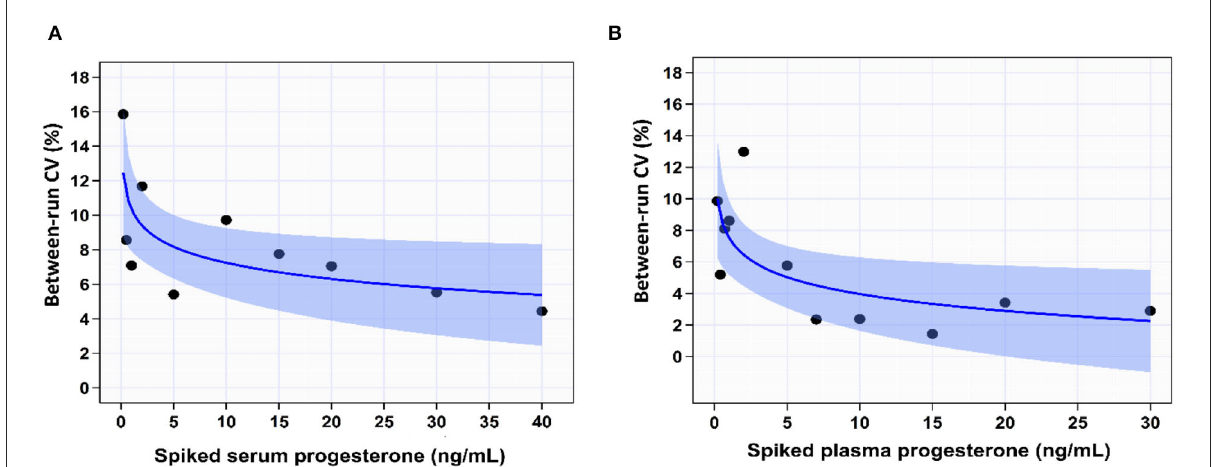
FIGURE3 The coefficient of variation percentage (CV%) indicated the between-run precision of IMMULITE ® 2000 XPi P4 immunoassay across the spiked serum (A) and plasma (B) progesterone concentrations. The solid blue lines are the best-fit regression lines. The light blue shaded areas indicate the 95% confidence bands for the regression lines.